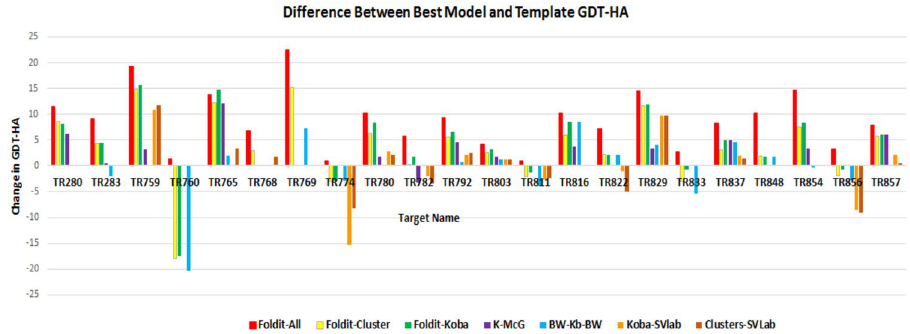
Figure 7. Comparison of GDT_HA differences between top model in each step of the refinement pipeline and the original model provided by the CASP11 organizers for each target. The steps are identified by color bars representing the difference between the GDT_HA of the starting model and the GDT_HA of (1) the best model among those generated by Foldit players (Foldit-All), (2) the best model among the clusters (Foldit-Cluster), (3) the best model among the clusters refined by KoBaMIN (Foldit-Koba), (4) the best selection by McGuffin (K-McG), (5) the best selection by Wallner/ProQ2 (BW-Kb-BW), (6) the best selection by SVLab of KoBaMIN- refined clusters (Koba-SVlab), and (7) the best selection by SVLab based on unrefined clusters (Clusters- SVLab).